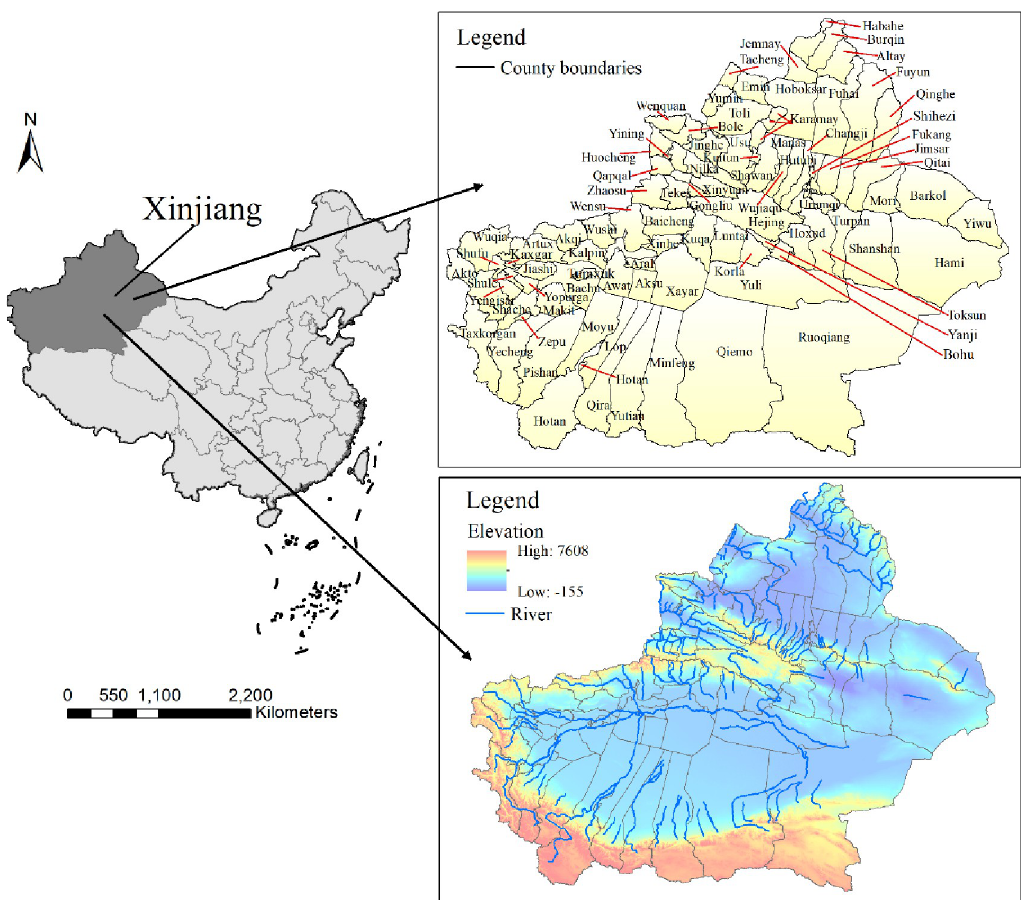
Fig 1. Map of the study area (location map, topographic map) (Based on map sources: GS (2016) 2556).